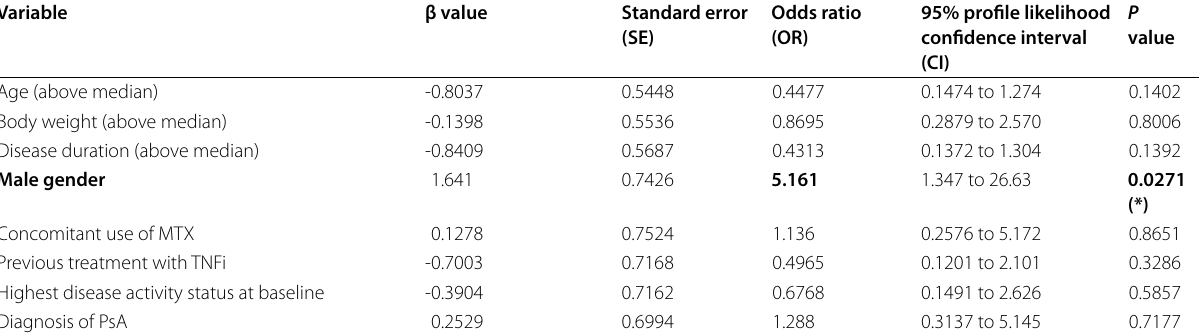
Table 3 Multiple logistic regression aimed to identify possible independent predictors of achievement of inactive disease (ASDAS-ID: ASDAS < 1.3) or remission (DAS28 < 2.6) after 52 weeks of treatment with Secukinumab in the whole cohort of patients with AS or PsA.